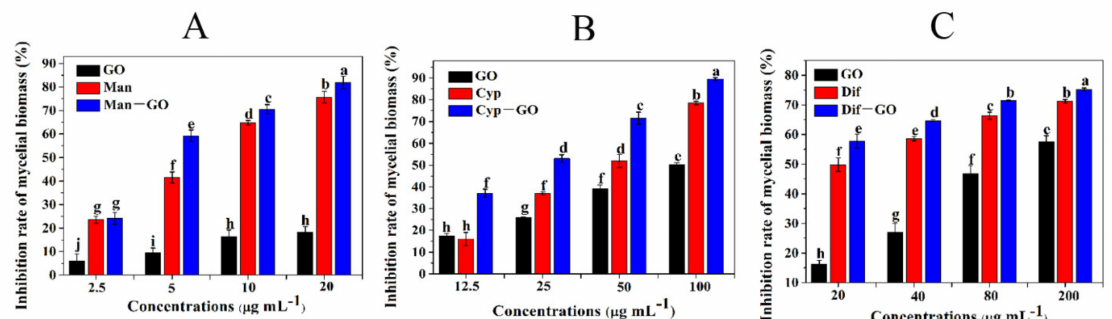
Figure 4. Inhibitory activities of GO, fungicides and GO–fungicides on the mycelial biomass of F. graminearum . The inhibition rate of mycelial biomass was tested at different concentrations of GO and Man–GO ( A ), Cyp–GO ( B ) and Dif–GO ( C ) for 120 h at 24 ± 2 ◦ C. Error bars represent the standard error (N = 4). Different lowercase letters indicate significant differences between treatments ( p <